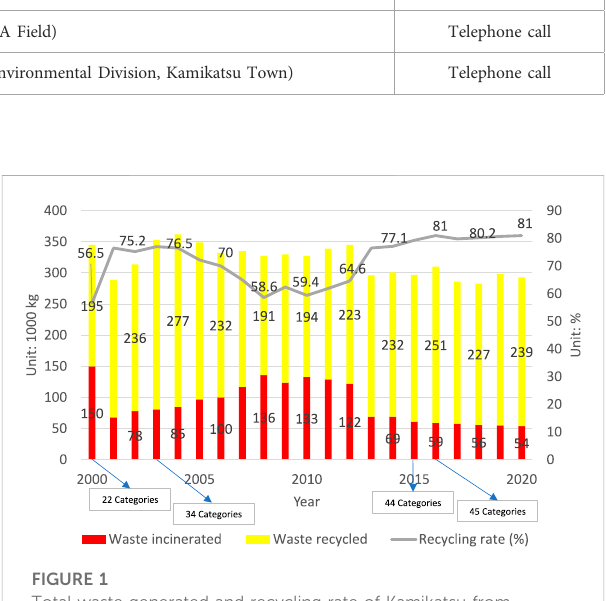
FIGURE 1 Total waste generated and recycling rate of Kamikatsu from 2000 – 2020 (adapted from Kamikatsu Town